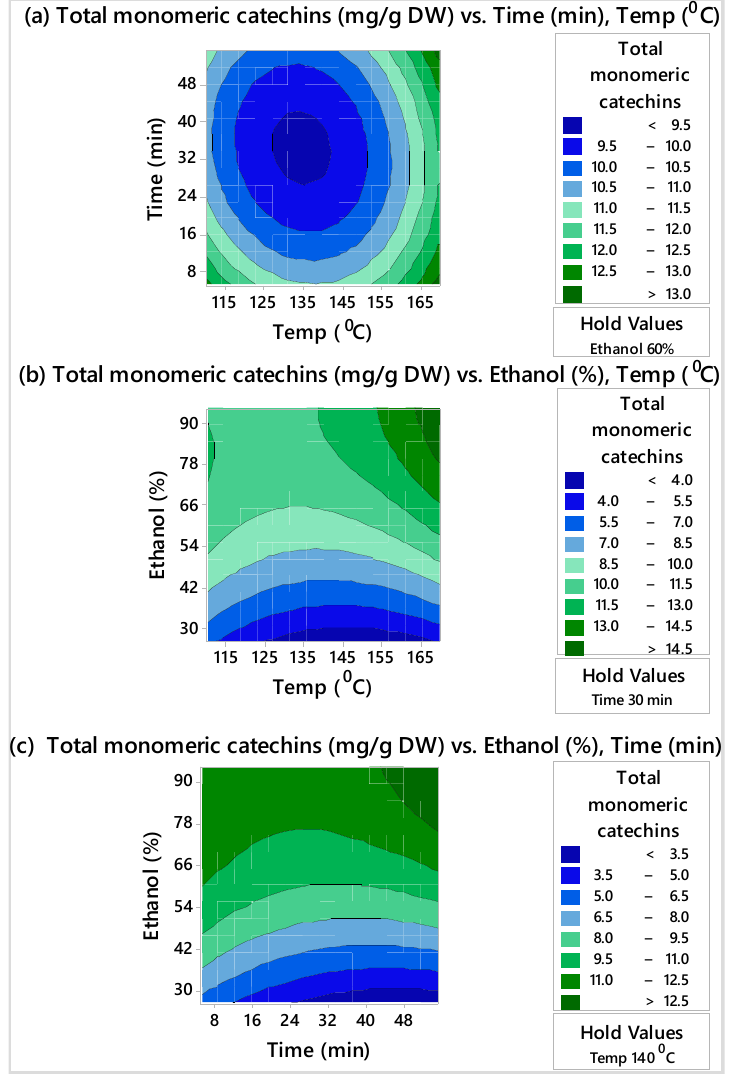
Figure 1. Contour plots of total monomeric catechins (mg / g DW) vs. ( a ) time (min) and temperature ( ◦ C) with ethanol held at 60%, ( b ) ethanol (%) and temperature ( ◦ C) with time held at 30 min, and ( c ) ethanol (%) and time (min) with temperature held at 140 ◦